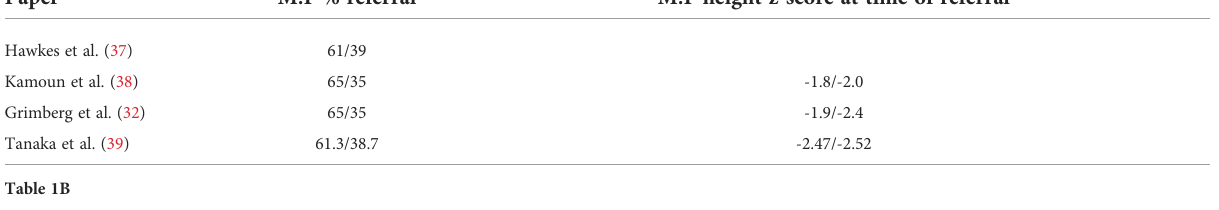
TABLE 1 Gender and Racial disparities in the diagnosis and treatment of Growth Hormone De fi ciency. Table 1A